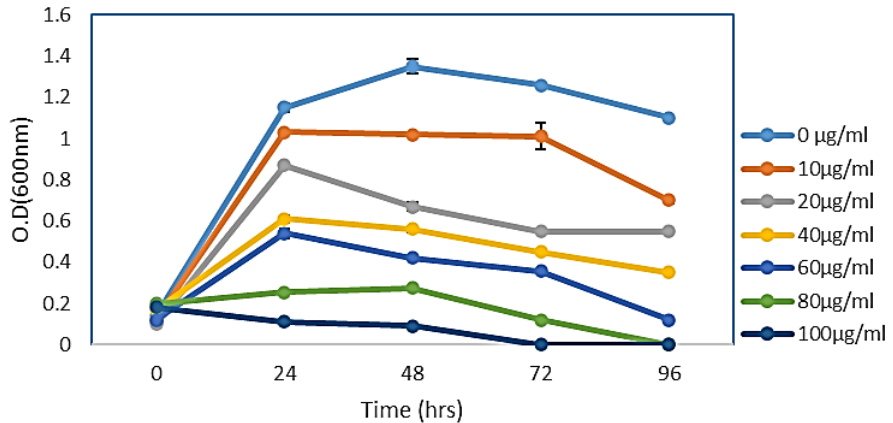
Figure 4. Growth curve dynamics of E. coli with CF-AgNPs solution. Each experiment was carried out in triplicate and the results are presented as mean values ± standard deviations (SD).